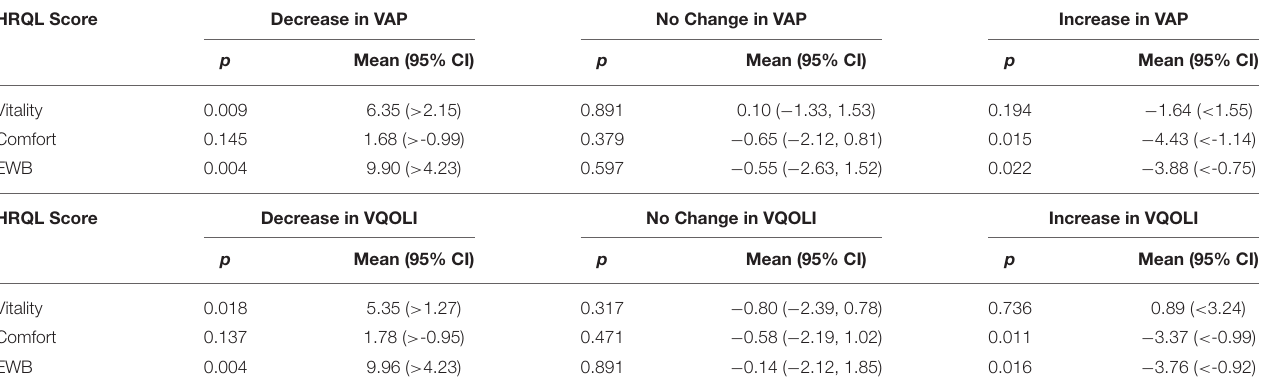
Values represent mean (and 95% confidence intervals) change in HRQL domain score, along with the associated P values.